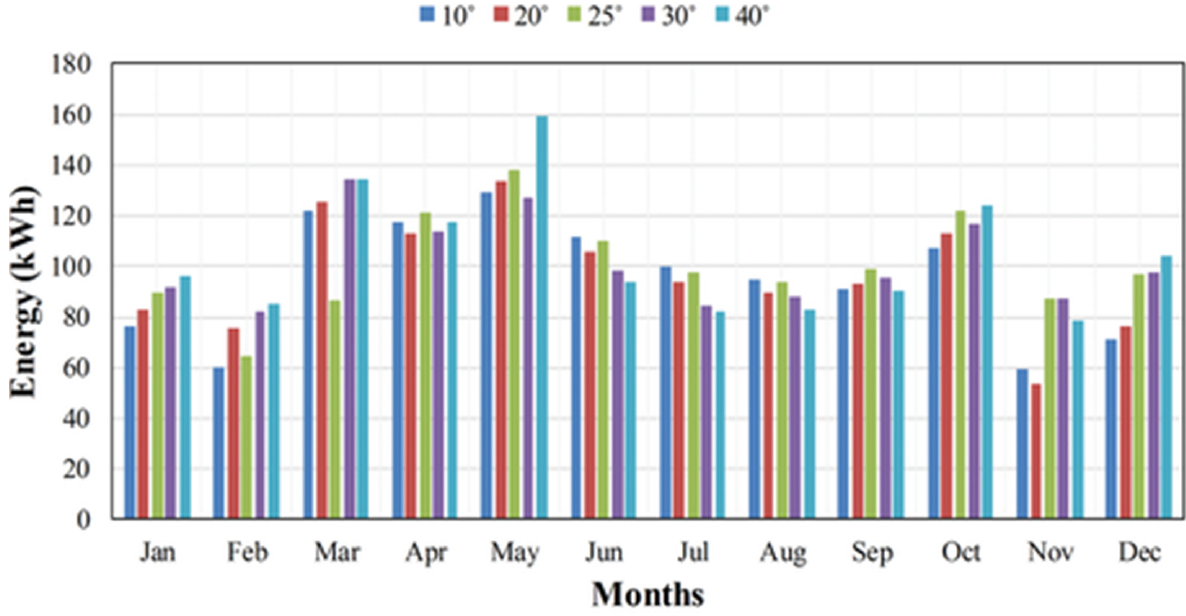
Figure 15. Peak power (watt) with time (day index) for the three PV panels [103].